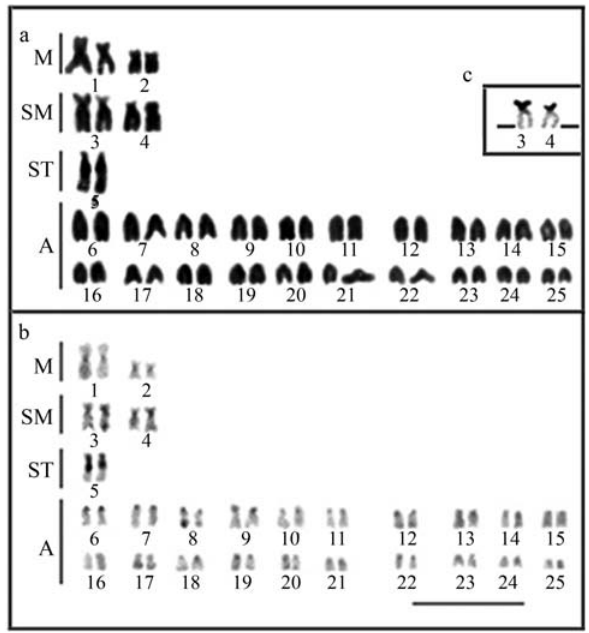
Figure 2 - Male (a) and female (b) Giemsa-stained karyotypes of Carnegiellastrigata .In(b)theAg-NOR-bearingchromosomesareshown intheinsert.C-bandedfemalekaryotypeshowingtheZZandZWchromo- somes in the insert (c). Bar - 10 μ